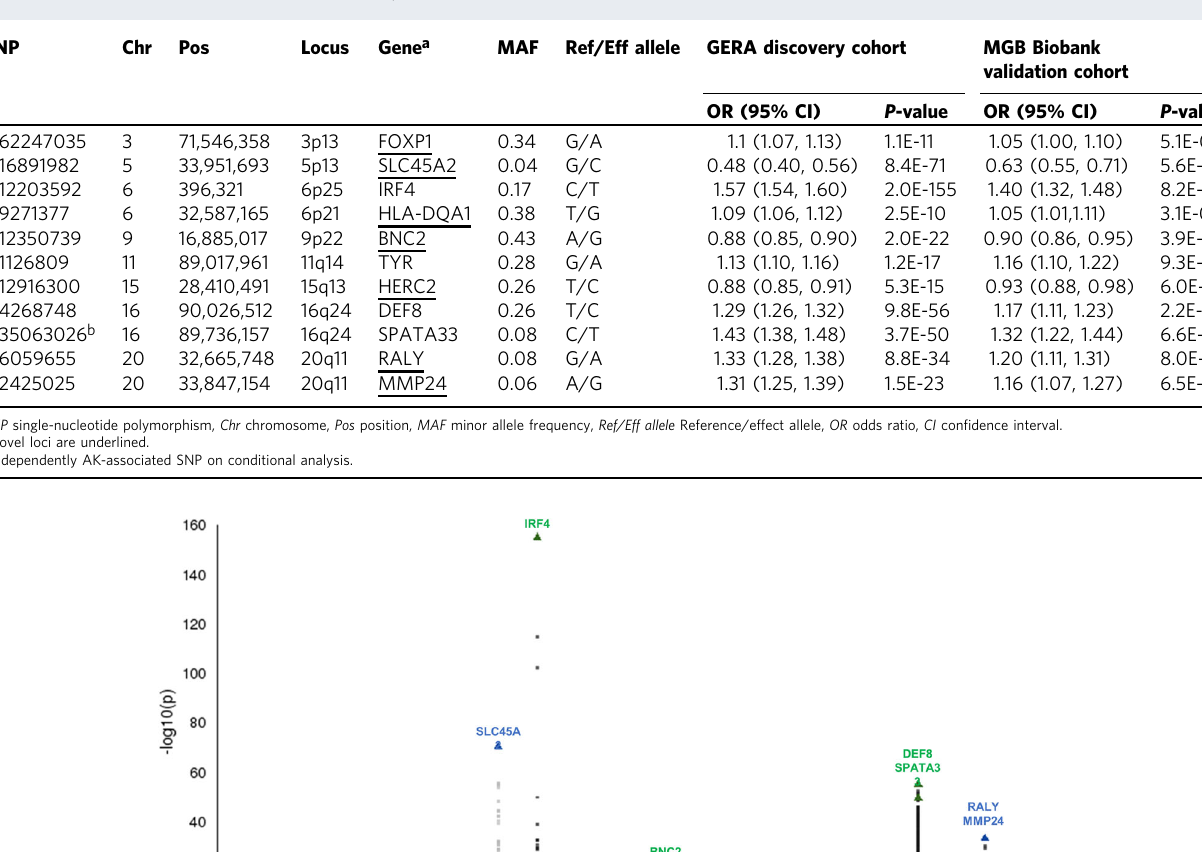
Table 2 Lead genome-wide signi fi cant SNP for each independent locus identi fi ed in the GERA discovery cohort ( n = 63,110) and validation in MGB Biobank cohort ( n = 29,130).